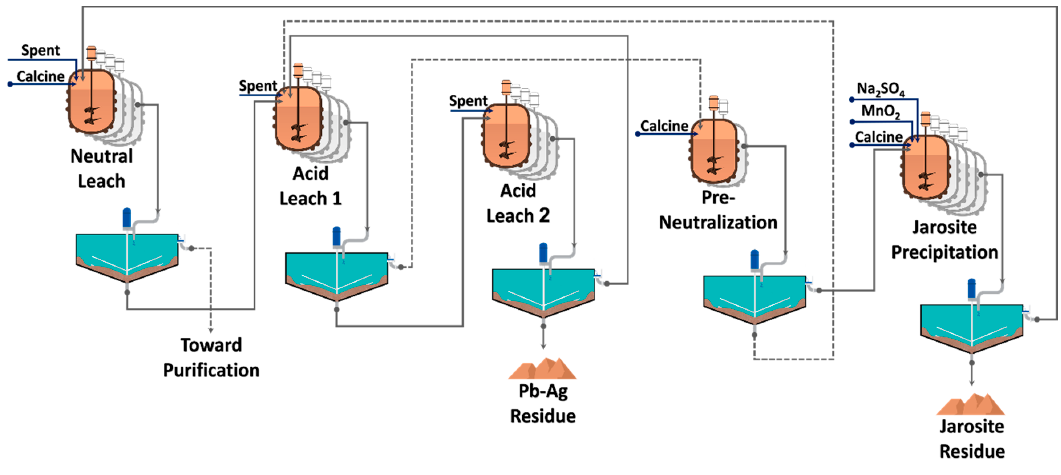
Figure 1. Schematic flow sheet of Bafgh Zinc Smelting Company’s (BZSC) leaching unit and jarosite precipitation line.